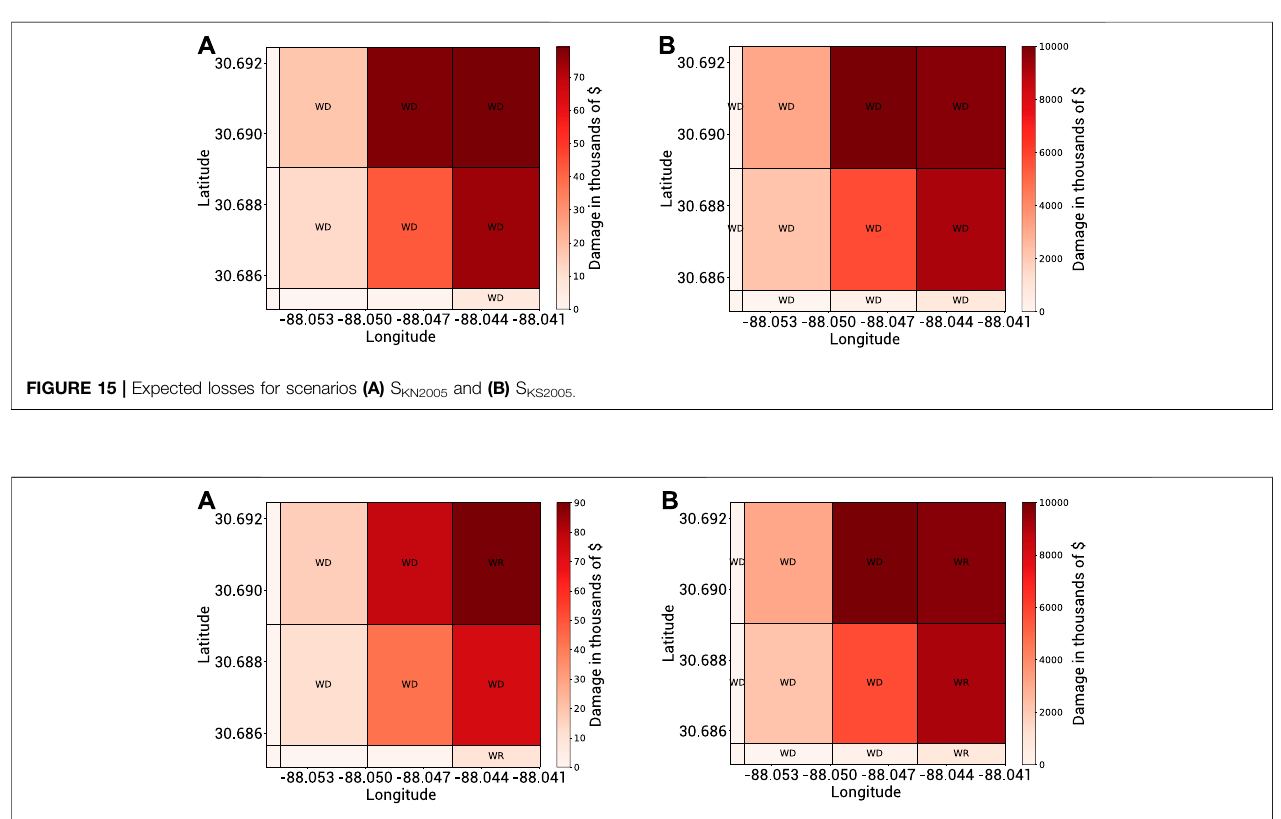
Frontiers in Built Environment |